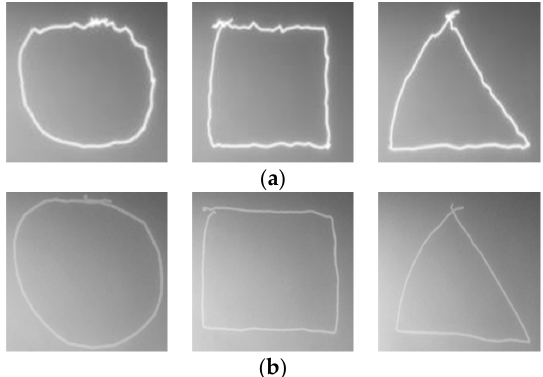
Figure 12. Touch path correction: ( a ) before touch path correction; ( b ) after touch path correction.